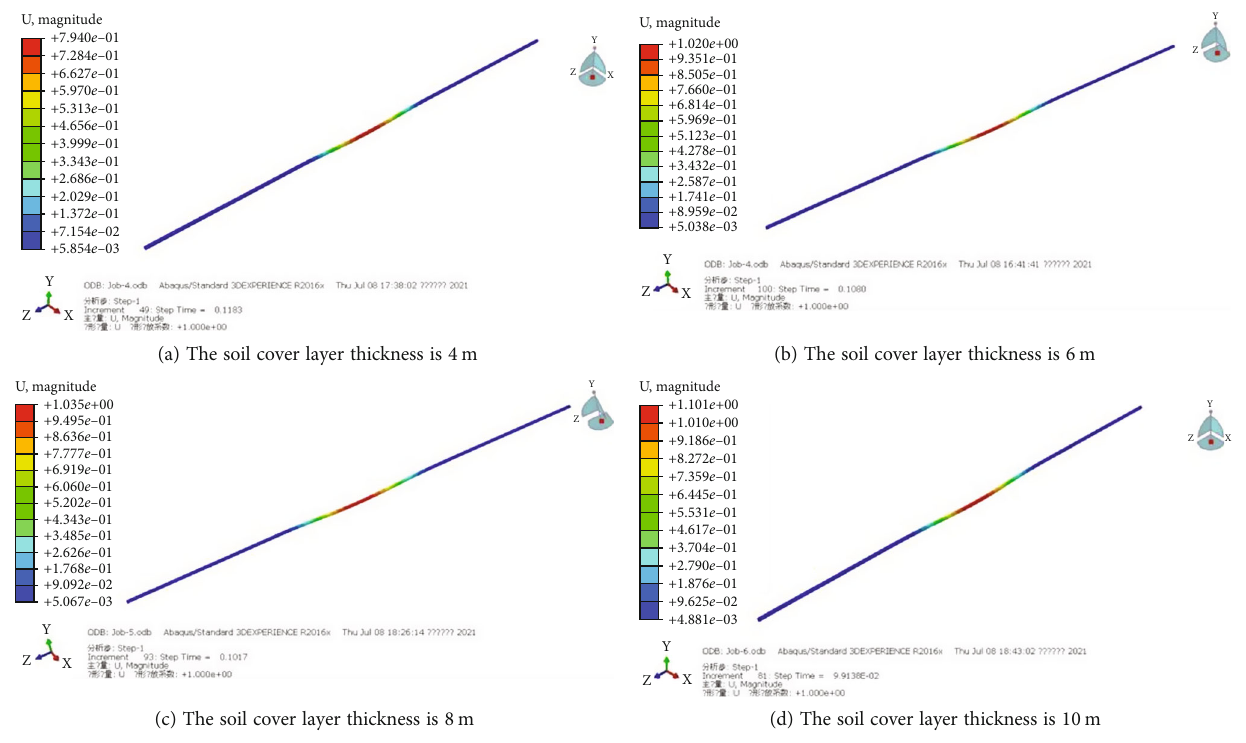
Figure 10: The pipeline ultimate deformation under di ff erent cover layer thicknesses.